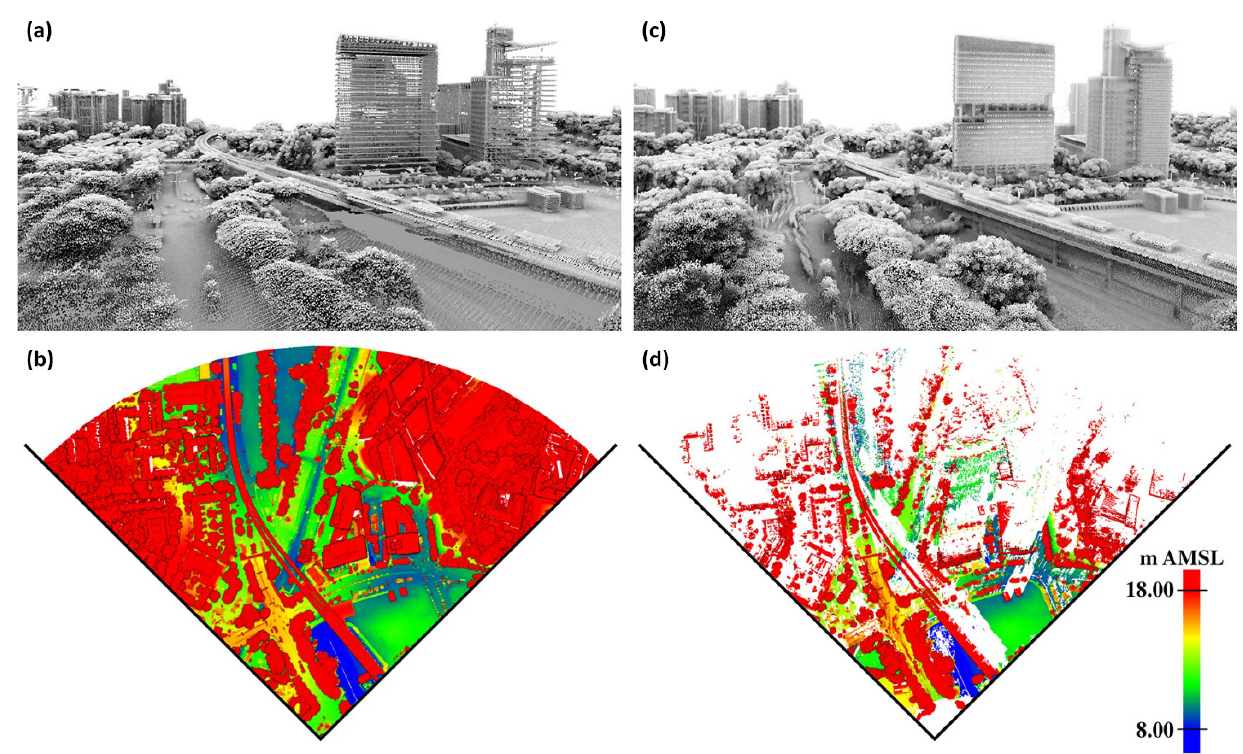
Figure 1. Geometric and visual documentation of a landscape near the Buona Vista station in Singapore. The point cloud models were recorded with aerial (a, b) and terrestrial (c, d) laser scanners. Data combined from three terrestrial scanning locations on rooftops close to the viewpoint of the perspective (c), are suitable for visualization purposes and resemble the perspective view with the aerial data (a). Explicit in plan view, there is insufficient information on features relevant to landscape design, as the topography is mostly occluded and trees are scanned on one side only (d). There are fewer occlusions during aerial laser scanning, which only needs to penetrate about 30 m of vegetation height to document the vertical structure and canopy